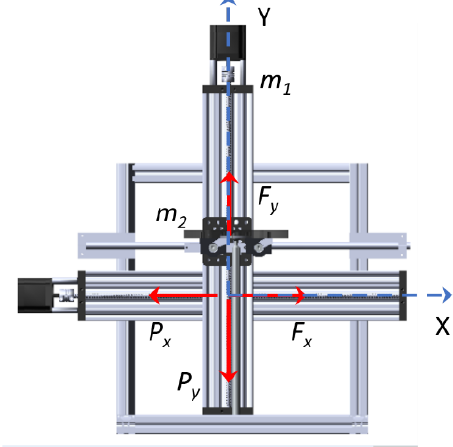
Figure 13. Free body diagram of the ankle rehabilitation machine.